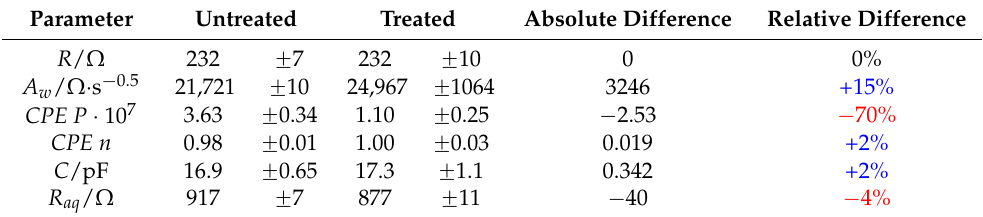
R aq / Ω 870 ˘ 9 951 ˘ 8 81 +9% Table 3. Parameter fit for Figure 11, case b . The errors represent the quality of the fit for each element. Blue and red font colours are used to highlight an increasing or decreasing trend, respectively. Parameter Untreated Treated Absolute Difference Relative Difference R / Ω 232 ˘ 7 232 ˘ 10 A w / Ω ¨ s ´ 0.5 ˘ 0.25 ´ 2.53 ´ 70% CPE n 0.98